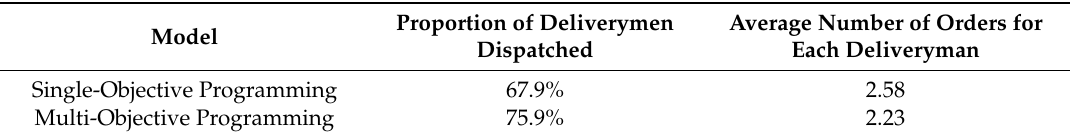
Table 5. Comparison of order dispatching and the combination between single-objective programming and multi-objective